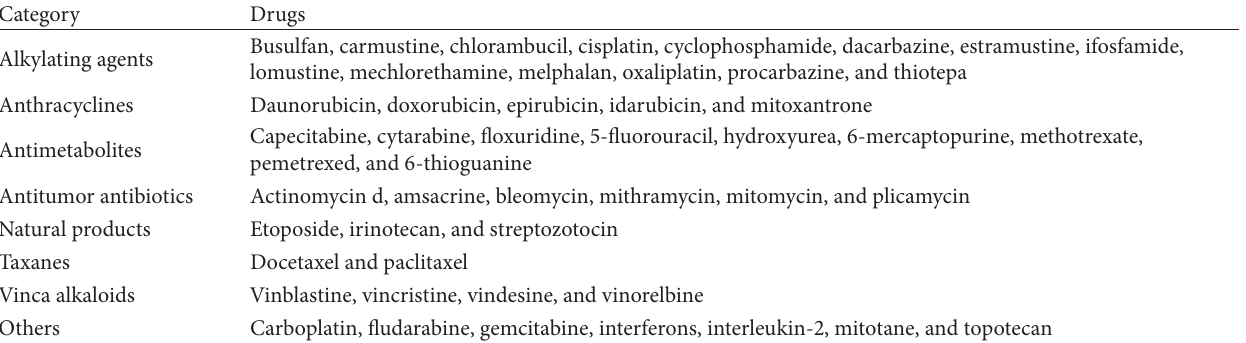
Table 2: A summary of mucosatoxic chemotherapy agents (data adapted from K¨ostler et al., 2001 [46], and Saadeh, 2005